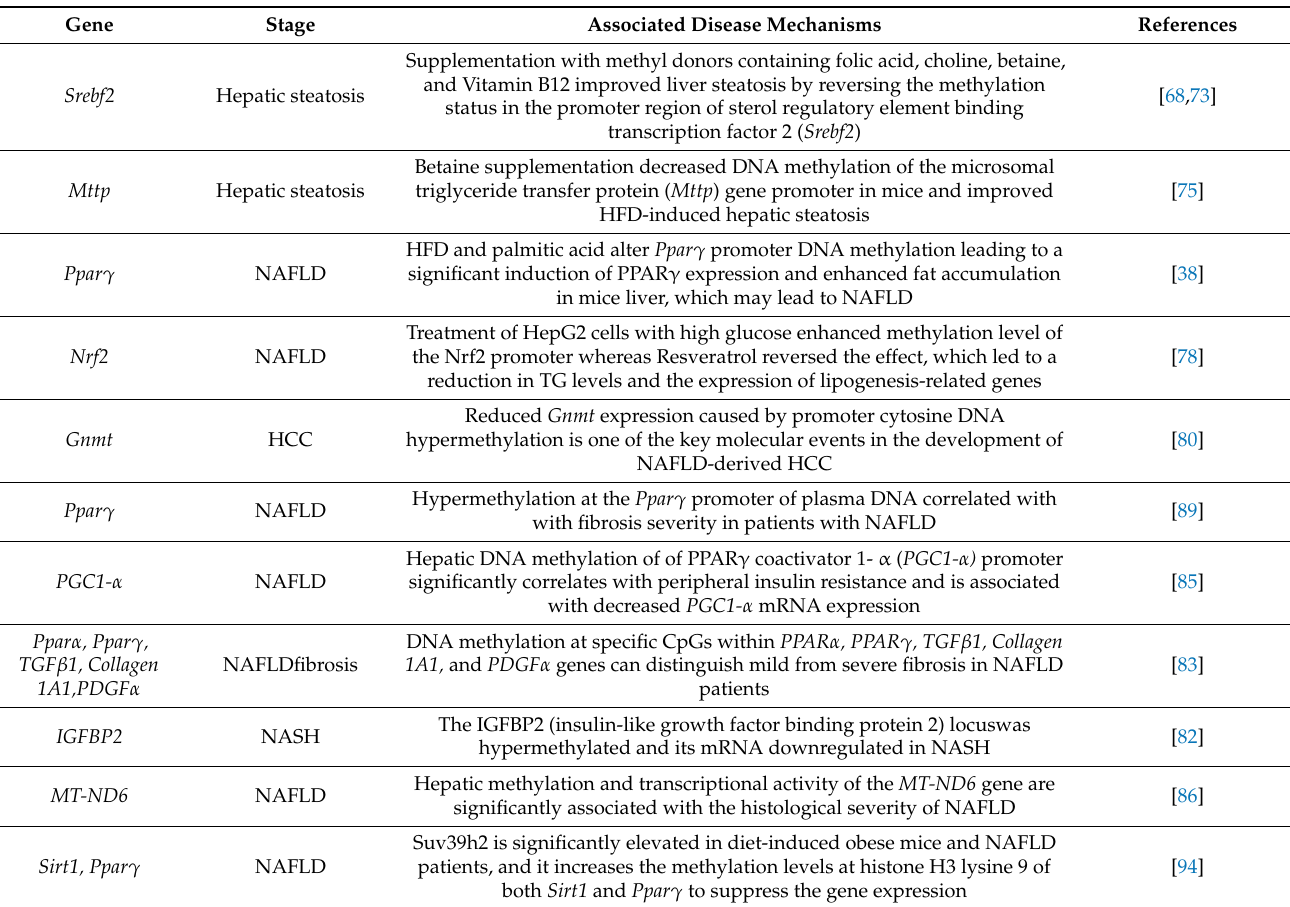
Table 1. Relevant DNA methylation alterations associated with gene expression in nonalcoholic fatty liver disease. Gene Stage Associated Disease